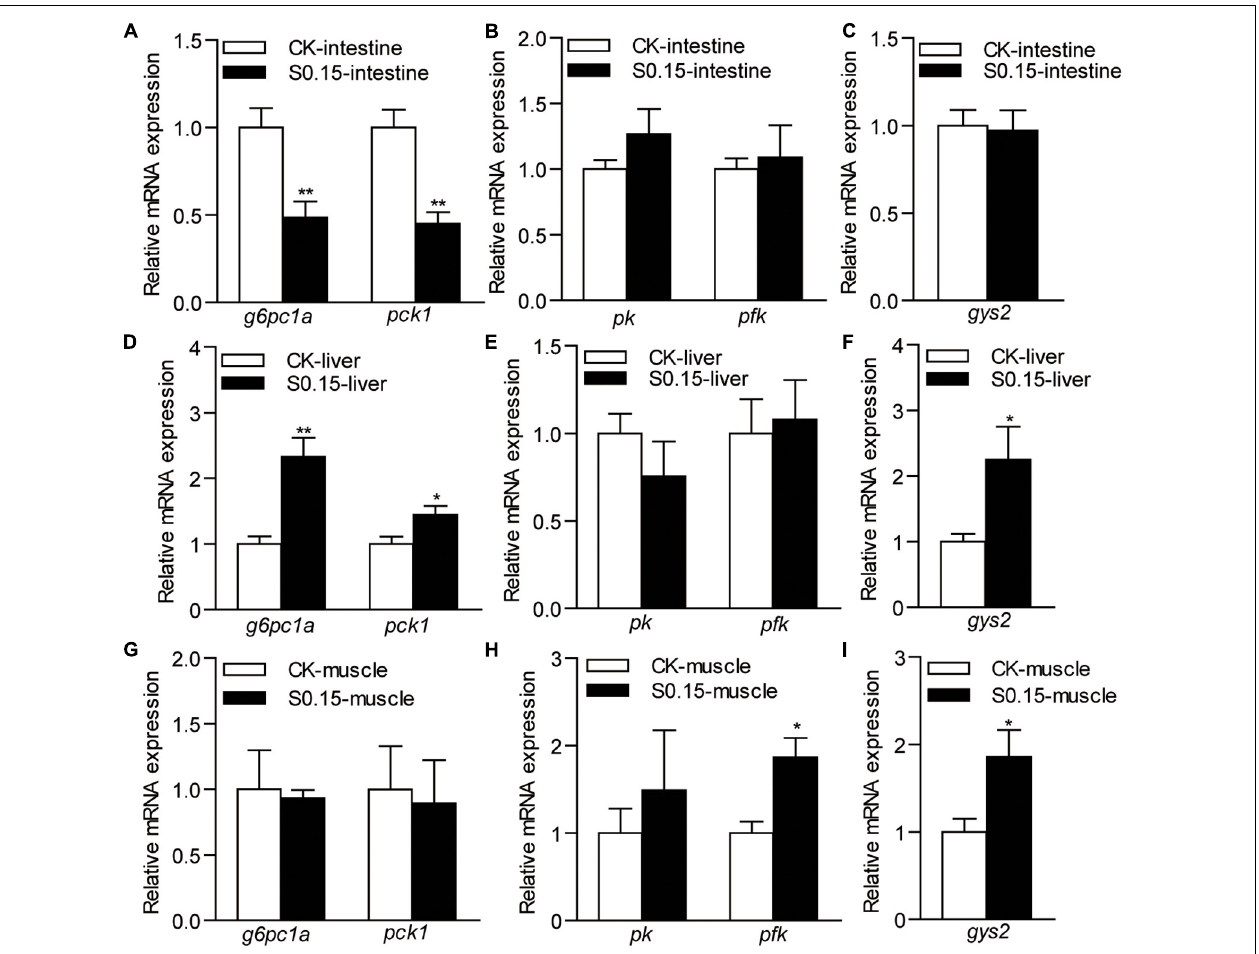
FIGURE 7 | The expression of glucose metabolism-related genes in zebrafish fed the CK or S0.15 diet for 4 weeks. (A) Gluconeogenesis-, (B) glycolysis-, and (C) glycogen synthesis-related genes in the intestine. (D) Gluconeogenesis-, (E) glycolysis-, and (F) glycogen synthesis-related genes in the liver. (G) Gluconeogenesis-, (H) glycolysis-, and (I) glycogen synthesis-related genes in the muscle. Values are means ± SEMs ( n = 6 biological replicates). * p < 0.05, ** p < 0.01. CK, control-check diet; S0.15, 0.15% succinate-supplemented diet.